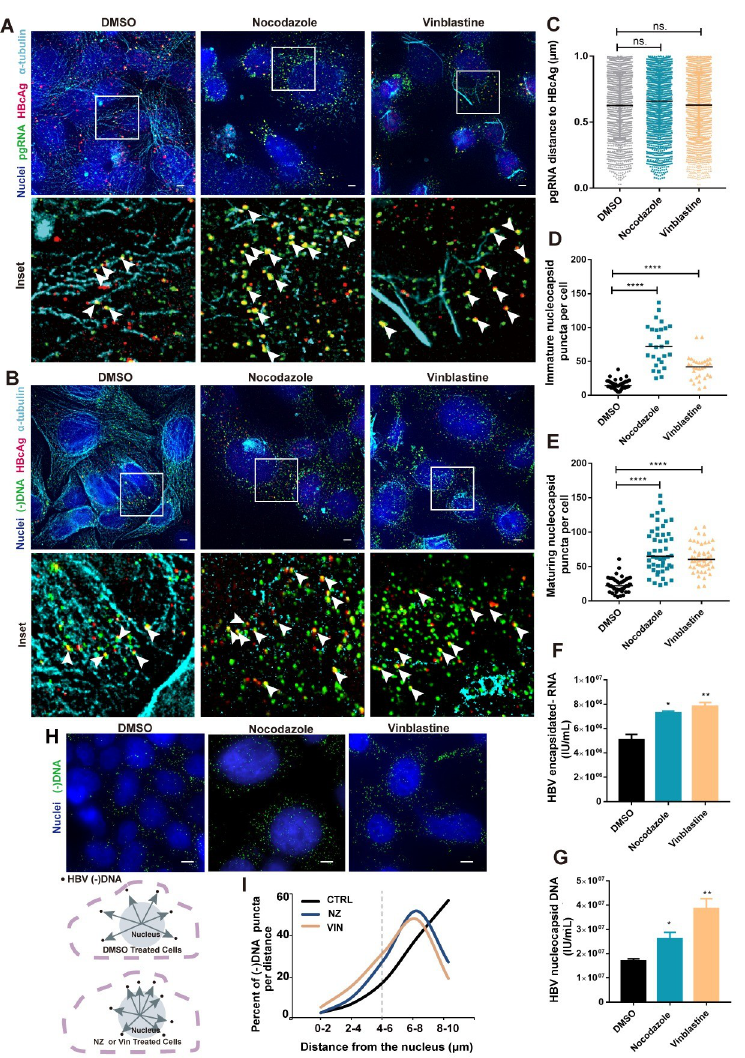
Fig 6. Effects of MTs disruption on HBV nucleocapsid formation. HepAD38 cells were treated with Nocodazole or Vinblastine for 24 h before fixation and processed for HBV pgRNA (A) or (-) DNA (B), HBcAg and α -tubulin detection. White arrows indicate the pgRNA or (-) DNA were colocalized with HBcAg. Scale bar, 4 μ m. (C) Analyzing pgRNA distance to its closest HBcAg within 1 μ m using Huygens in FISH images. (D, E) Quantitative analysis of HBV immature and maturing nucleocapsid puncta in single cell using Huygens in FISH images. More than 15 cells per group was counted. Intracellular HBV encapsidated pgRNA (F) and nucleocapsid DNA (G) were quantified by real- time PCR. (H, I) Representative images, schematics and measurements of cellular distribution of viral (-) DNA compared to the nucleus in DMSO or MTIs-treated cells using Huygens. More than 15 cells per group was counted. NZ, Nocodazole; VIN, Vinblastine. � P < 0.05, �� P < 0.01, ���� P < 0.0001. ns: no significance. (C-E): Mann-Whitney U-test; (F, G): Student’s t -test, the data are representative of three independent